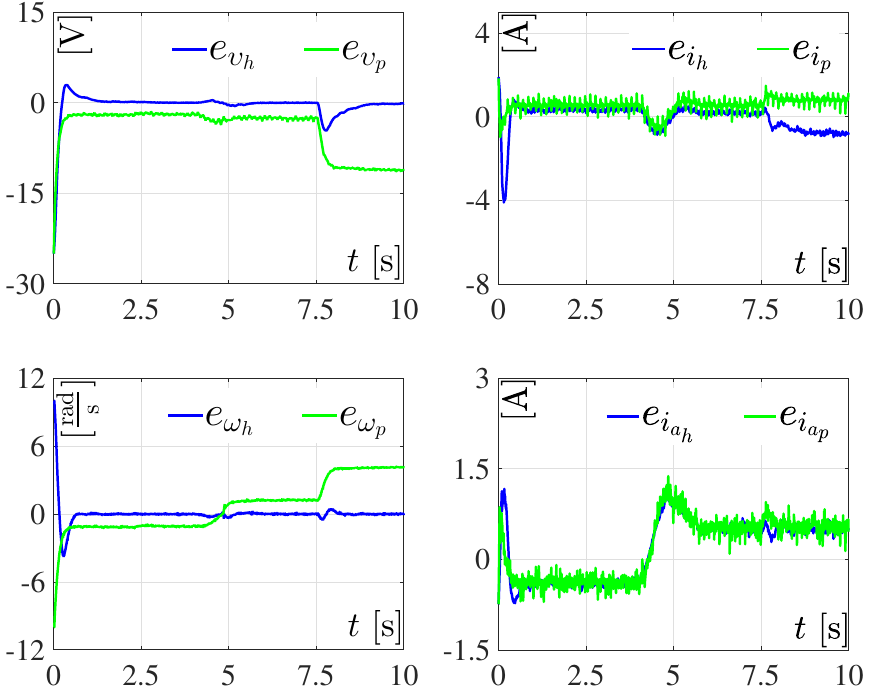
Figure 8. Tracking errors of the system in closed-loop, when the abrupt change in E (Equation (47)) is considered. In these graphics the tracking errors associated with the hierarchical controller are denoted as e υ , e i , e ω , and e i , while the errors related to the passive controller are represented by e υ h h ah h and e i ap